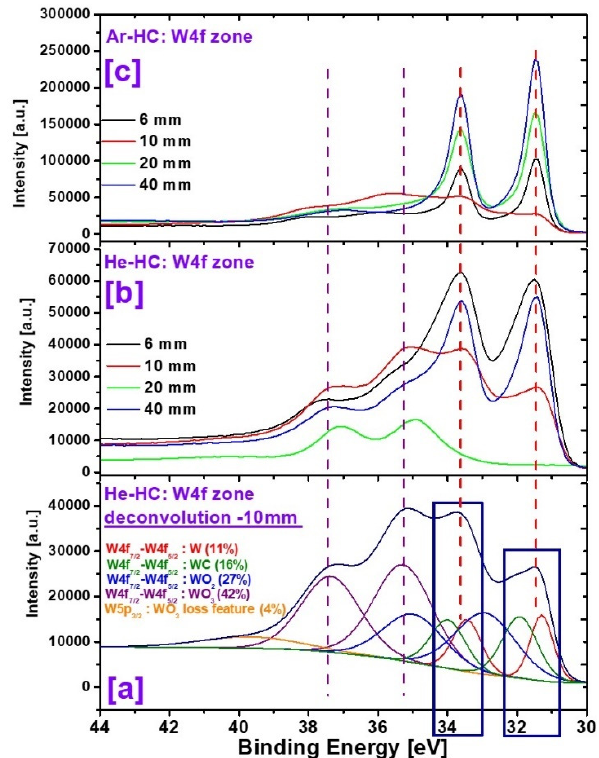
Figure 17. XPS analysis of the obtained particles in HC discharge for Ar and He plasmas: The influence of distance upon W4f zone: ( a ) W4f deconvolution of He-HC at 10 mm; ( b ) W4f zone of He-HC for 6–40 mm; ( c ) W4f zone of Ar-HC for 6–40 mm.